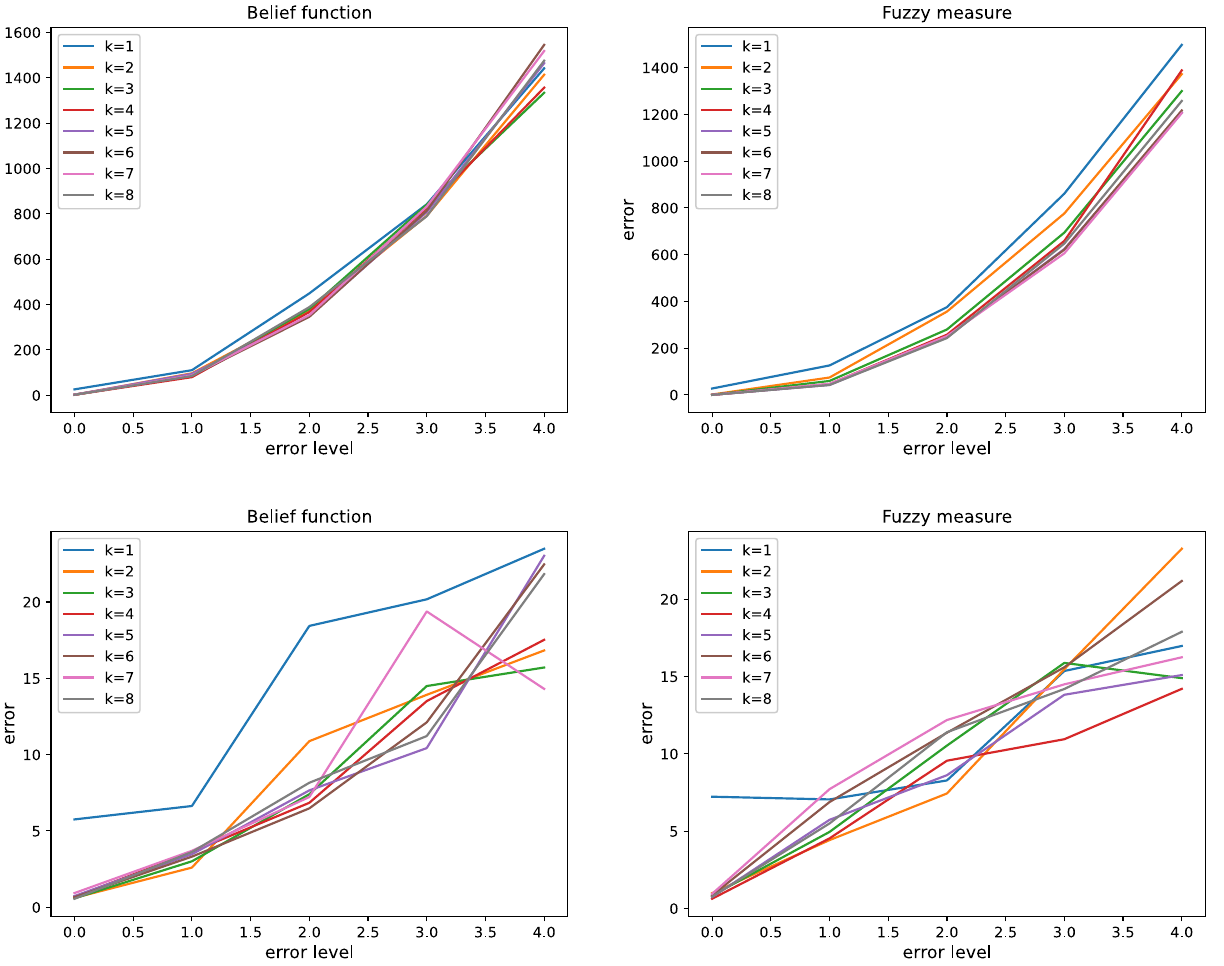
Fig. 3 Error for the training (top) and test (bottom) sets when the measure is a belief function (left) and when it is an arbitrary measure (right). Mean of 10